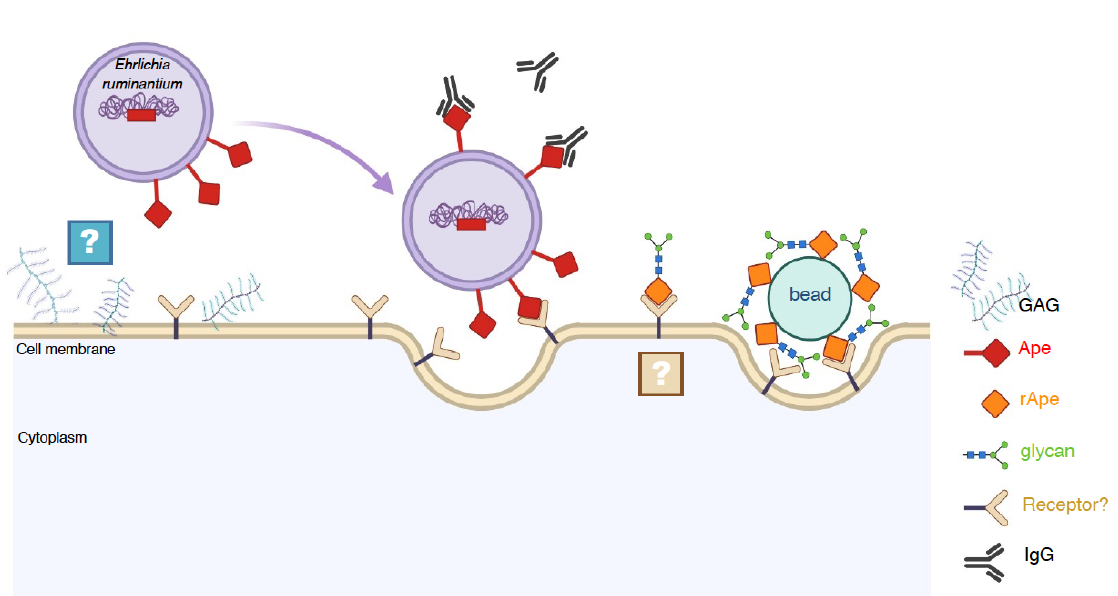
Figure 9. Schematic representation of Ehrlichia ruminantium binding to mammalian cells and rApe interaction with the host cell surface. Ape is located at E. ruminantium outer membrane and is recognized by antibody from sera of vaccinated animals. E. ruminantium can adhere and enter into BAEC but infection is reduced when GAG like chondroitin and dermatan sulfate are degraded. The recombinant version of E. ruminantium , rApe, is glycosylated and latex beads coated with rApe bind to BAE cell surface and start to enter in BAEC, in a similar manner that of E. ruminantium. Whether Ape binds to a cellular receptor and the following triggered signaling cascade remain to be